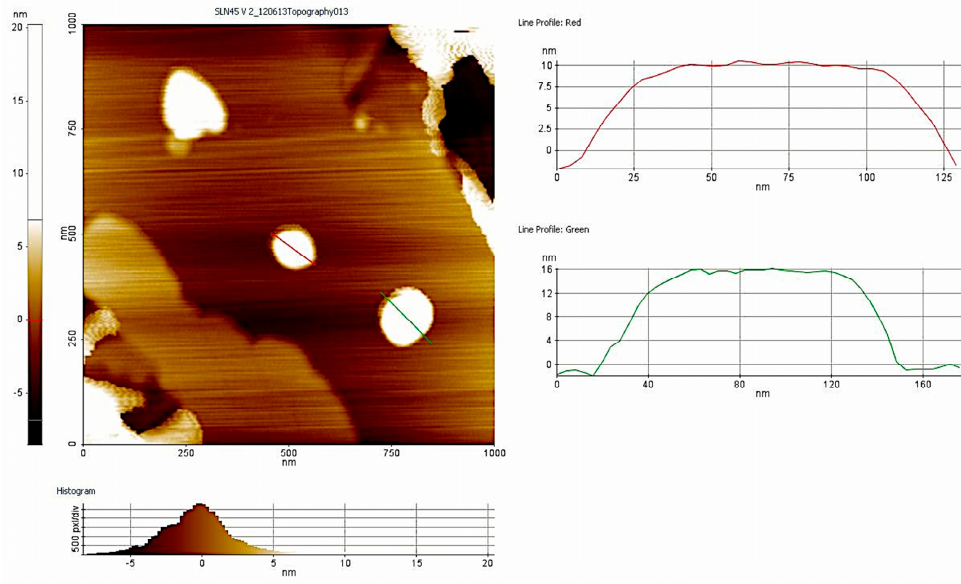
Figure 1. Size measurement performed by AFM imaging. Diameter was around 150